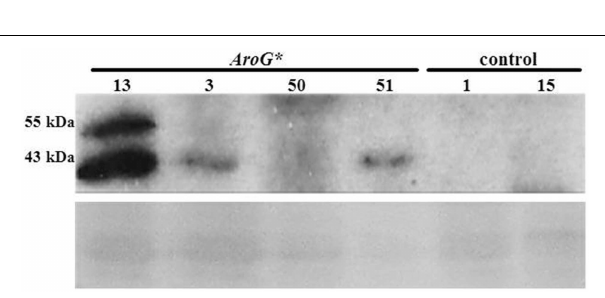
FIGURE 2 | Accumulation of AroG * protein in four transgenic Gamay cell culture lines. Immunoblot analysis was performed on protein extracts of the four AroG * lines and two controls, using anti-HA antibody (1:1000). The major protein band at 43kDa and the additional band slightly above it represent the mature and the unprocessed AroG * protein, respectively. Ponceau staining of the gel indicates similar protein loading. The relative intensity of the 43 KDa band was 10.9:3.7:1:2.5 in lines 13, 3, 50, and 51